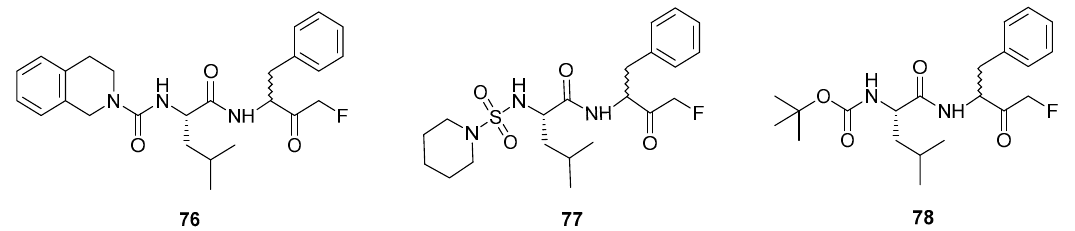
Figure 3. Peptidyl FMKs capable of inhibiting calpain I [2].